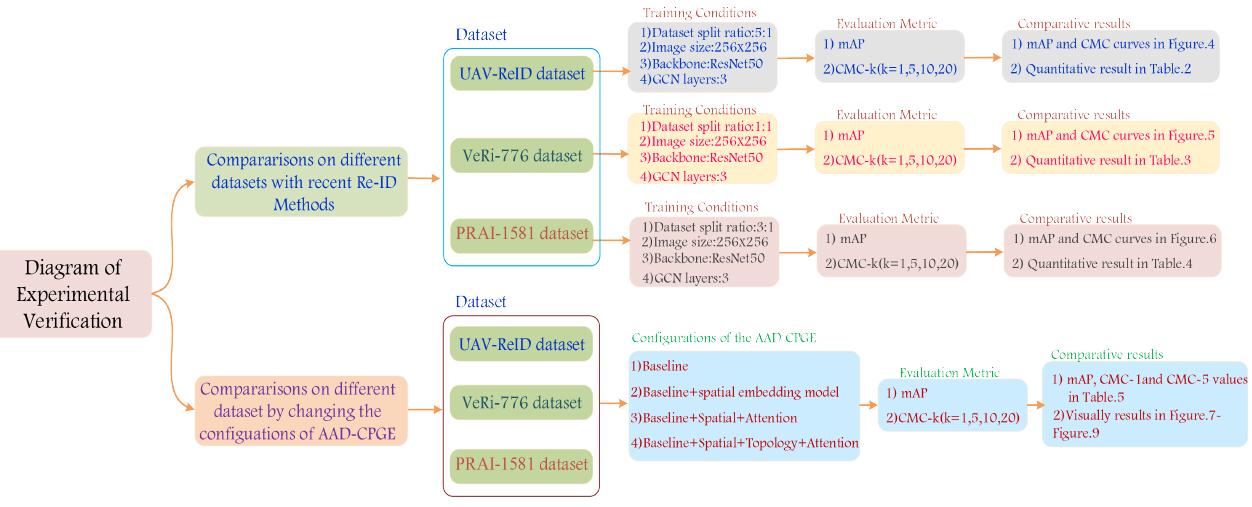
Figure 4. The whole diagram of experimental verification on different